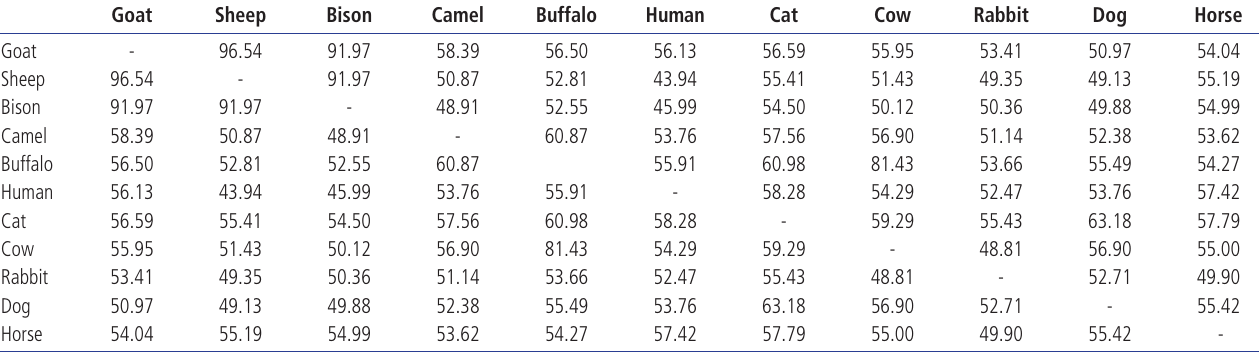
Similar values in the under triangle (%).